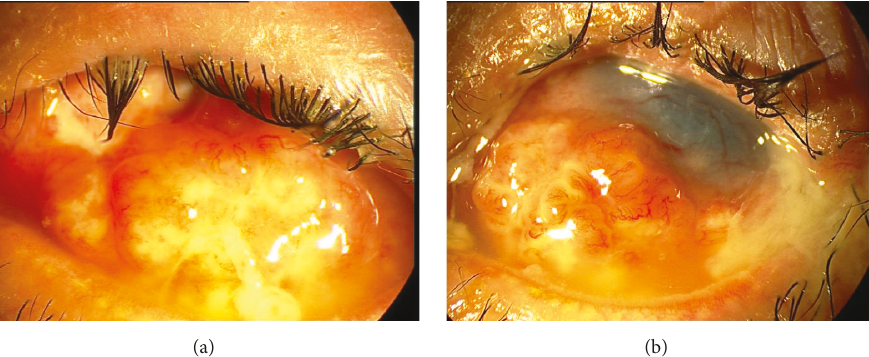
Figure 1: ((a) and (b)) Photo-slit lamp images demonstrating the rapid development of a conjunctival mass lesion within a few weeks on the patient’s left eye.